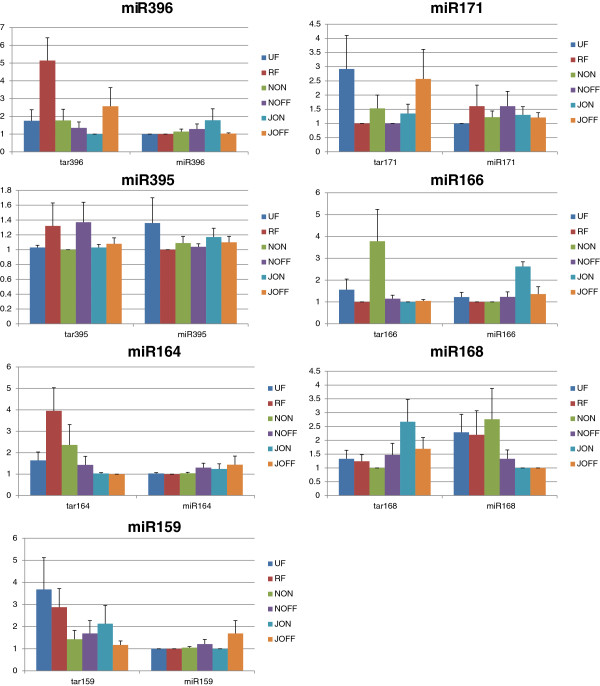
qRT-PCR validation of selected miRNA and their target genes. The histograms show the relative values for the quantified expressions of seven miRNA and their target genes in six olive tree samples. The analyses were performed as triplicates, and the error bars indicate the standard deviations.